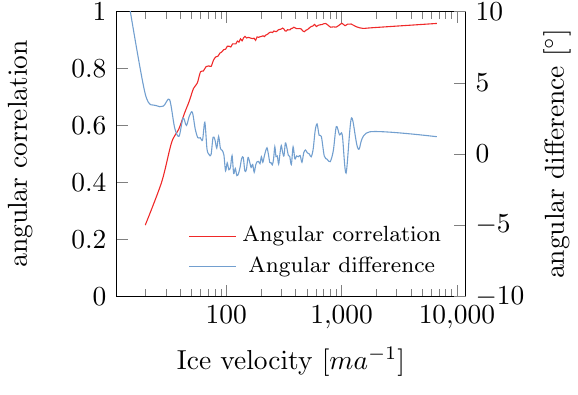
Figure 1. Correlation and mean difference of the TanDEM-X global DEM aspect angle (direction of steepest slope) and the flow angle of the TSX velocity vectors. The comparison is carried out over the entire SPI area for velocity bins that contain an equal number of points.